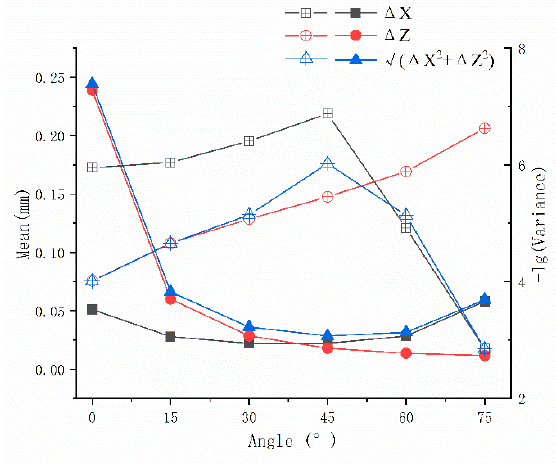
Figure 4. Mean and variance of the uncertain region size in the nearest circular area.